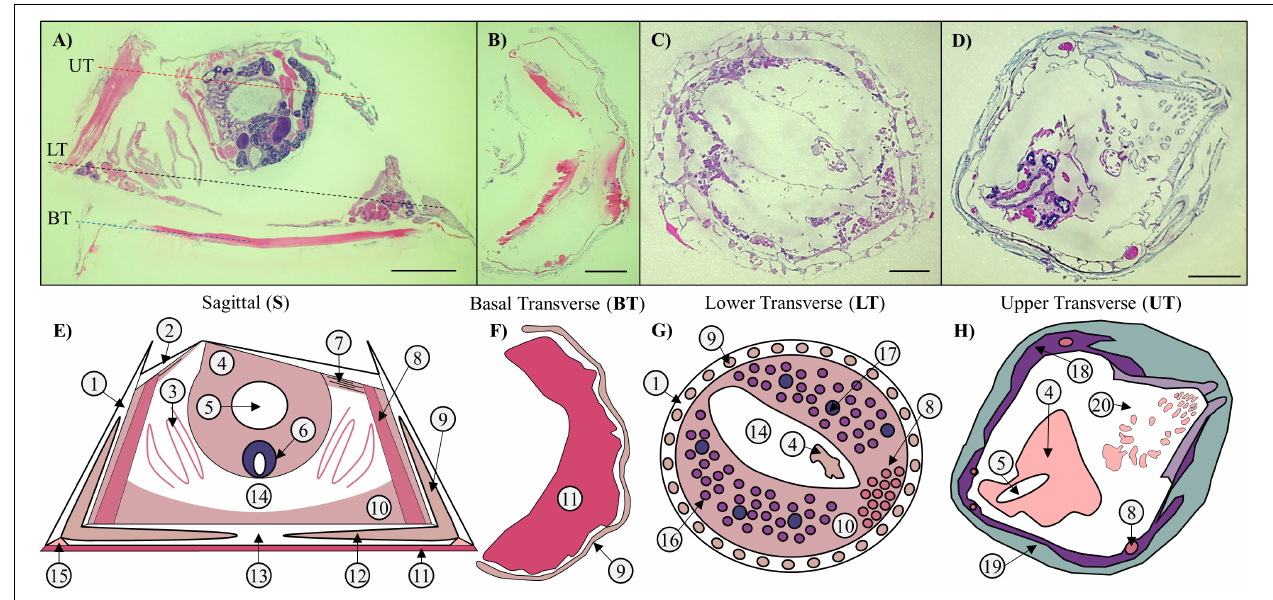
FIGURE 1 | Sections and schematics of Amphibalanus amphitrite anatomy. (A–D) H&E stained sagittal (S) and transverse sections of a decalcified adult. The dashed lines in panel (A) indicate the location of the transverse sections along the sagittal plane: blue = basal transverse (BT) sections of a sagittally bisected individual; black = lower transverse (LT) sections; and red = upper transverse (UT) sections. Sections through the middle of the barnacle of the barnacle contain a collection of most, if not all, types of tissue present in an adult barnacle. (B) BT sections are cut through the basal region directly attached to the substrate and below the previous location of base plate, and contain mostly cuticle. (C) LT sections are cut above the base plate in the sub-mantle tissue, and contain mostly female reproductive tissues. (D) UT sections are cut close to the top of the barnacle, near the operculum, and contain lining tissue against the inside of the parietal plates, a small portion of the main body, and parts of the cirri. Scale bar = 1 mm for panels (A–D) . (E–H) Accompanying schematics depicting major anatomical features: 1. Parietal plates; 2. Opercular plates; 3. Gills; 4. Main body; 5. Digestive tract; 6. Testes; 7. Connective tissue; 8. Muscle; 9. Longitudinal canal tissue; 10. Sub-mantle tissue; 11. Adhesive layer (cuticle + proteinaceous adhesive); 12. Lateral canal tissue; 13. Baseplate; 14. Mantle cavity; 15. Epithelial cells at leading edge; 16. Ovaries; 17. Cement glands; 18. Mantle; 19. Inner shell tissue; 20.